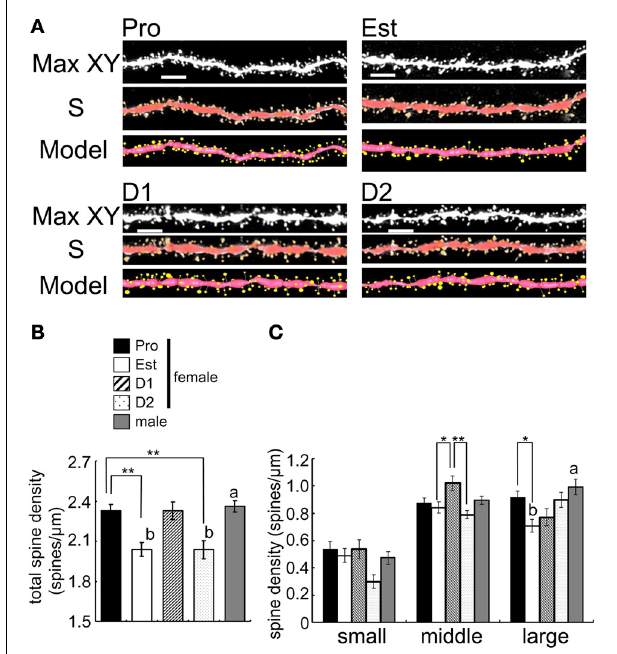
FIGURE 5 | Cyclic fluctuation of the density and morphology of spines across the estrous cycle in CA1 region of the female hippocampus (perfusion-fixed slices). (A) Spine images along the secondary dendrites in the stratum radiatum. Maximal intensity projections onto XY plane from z-series confocal micrographs (Max XY) for Pro, Est, D1, and D2. Spine images analyzed by Spiso-3D (S) and 3 dimensional model illustration (Model). (B) Total spine density of CA1 neurons of female and male hippocampus. From left to right, Pro (black column), Est (white column), D1 (hatched column), D2 (dotted column), and male (gray column). (C) Density of three subtypes of spines, i.e., small-head spines (small), middle-head spines (middle), and large-head spines (large). Male spine data are nearly the same as those of female at Pro. Vertical axis is the average number of spines per 1 μ m of dendrite. For each estrus stage of female or male, we investigated 3 rats, 6 slices, 12 neurons, 24 dendrites, and 3000–4000 spines. Female Pro is used for control. Statistical significance between 4 stages was calculated by One-Way ANOVA followed by Dunnett’s post-hoc comparison. ∗ p < 0 . 05; ∗∗ p < 0 . 01. Statistical significance with p < 0 . 01 was observed between male and female which are indicated by “a” or “b.” Scale bar, 5 μ m.